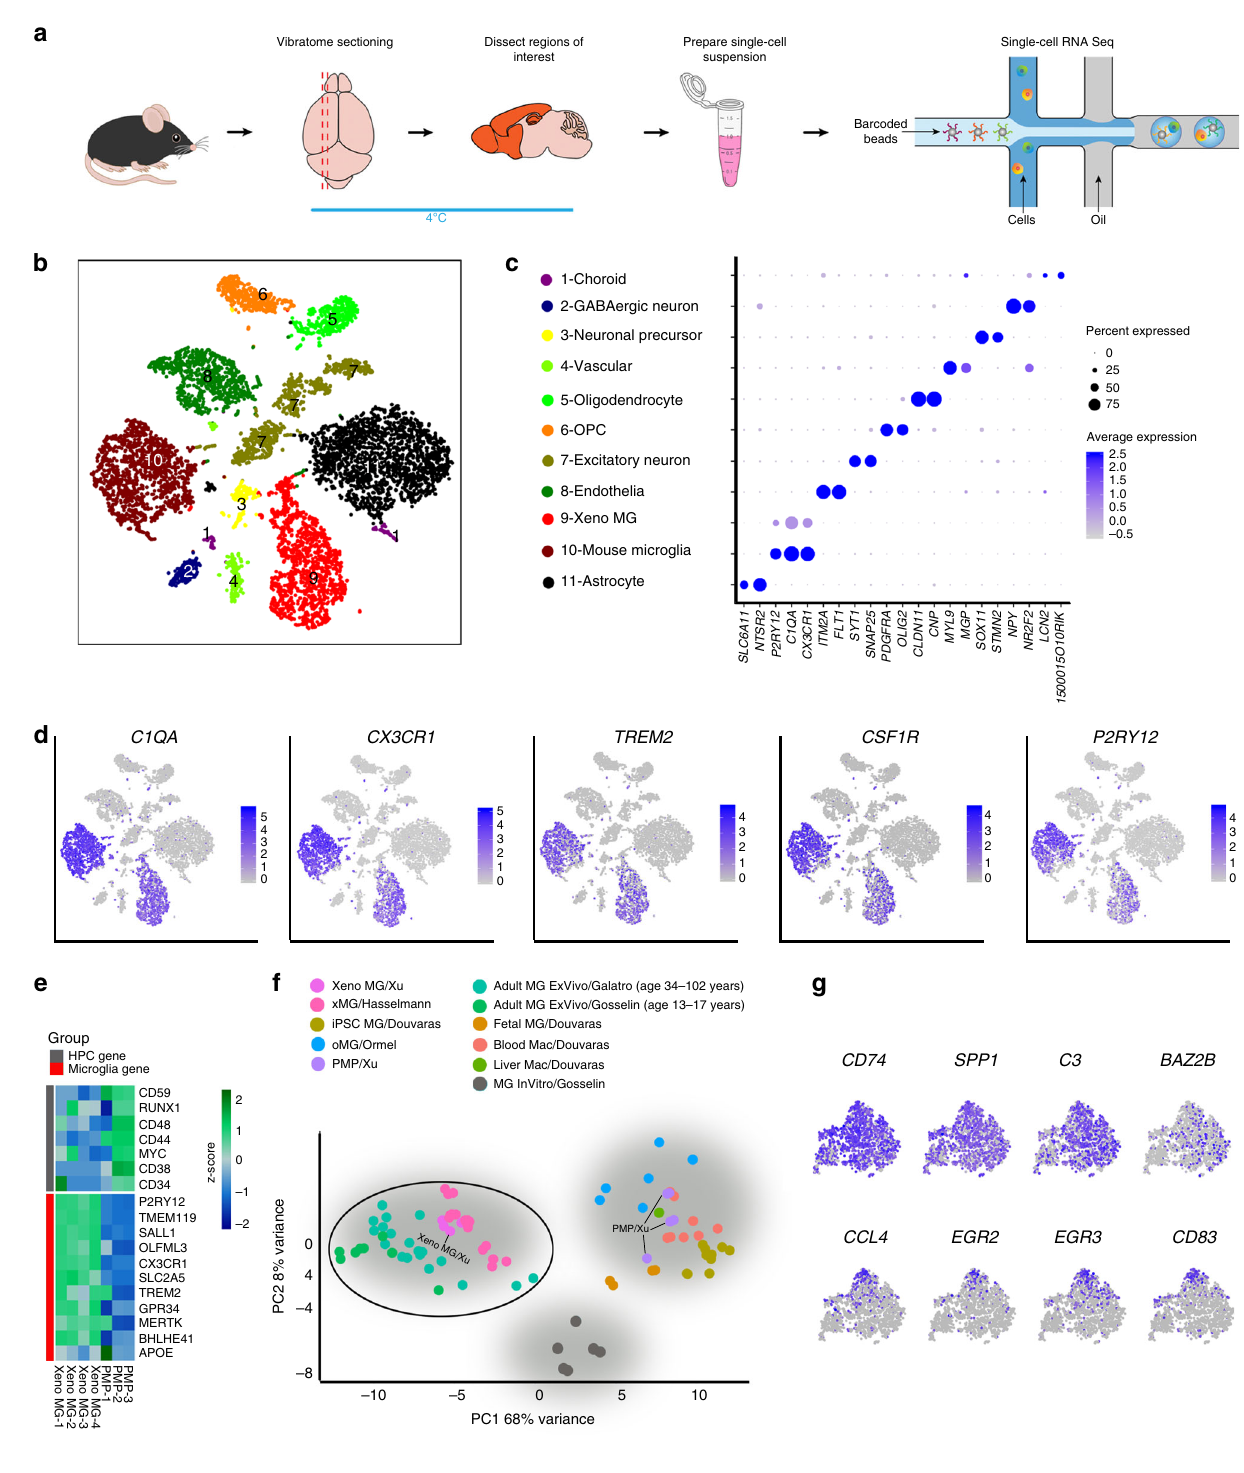
microglial state. Consistently, we found very minor expression of acute pro-in fl ammatory cytokines such as IL-1 β , IL-1 α , and TNF- α (Supplementary Fig. 8B). In contrast, the pro-in fl ammatory cytokine, IL-6 and an anti-in fl ammatory cytokine, IL-10, were nearly undetectable, and expression of these pro-in fl ammatory cytokines is often correlated with a longer-lasting in fl